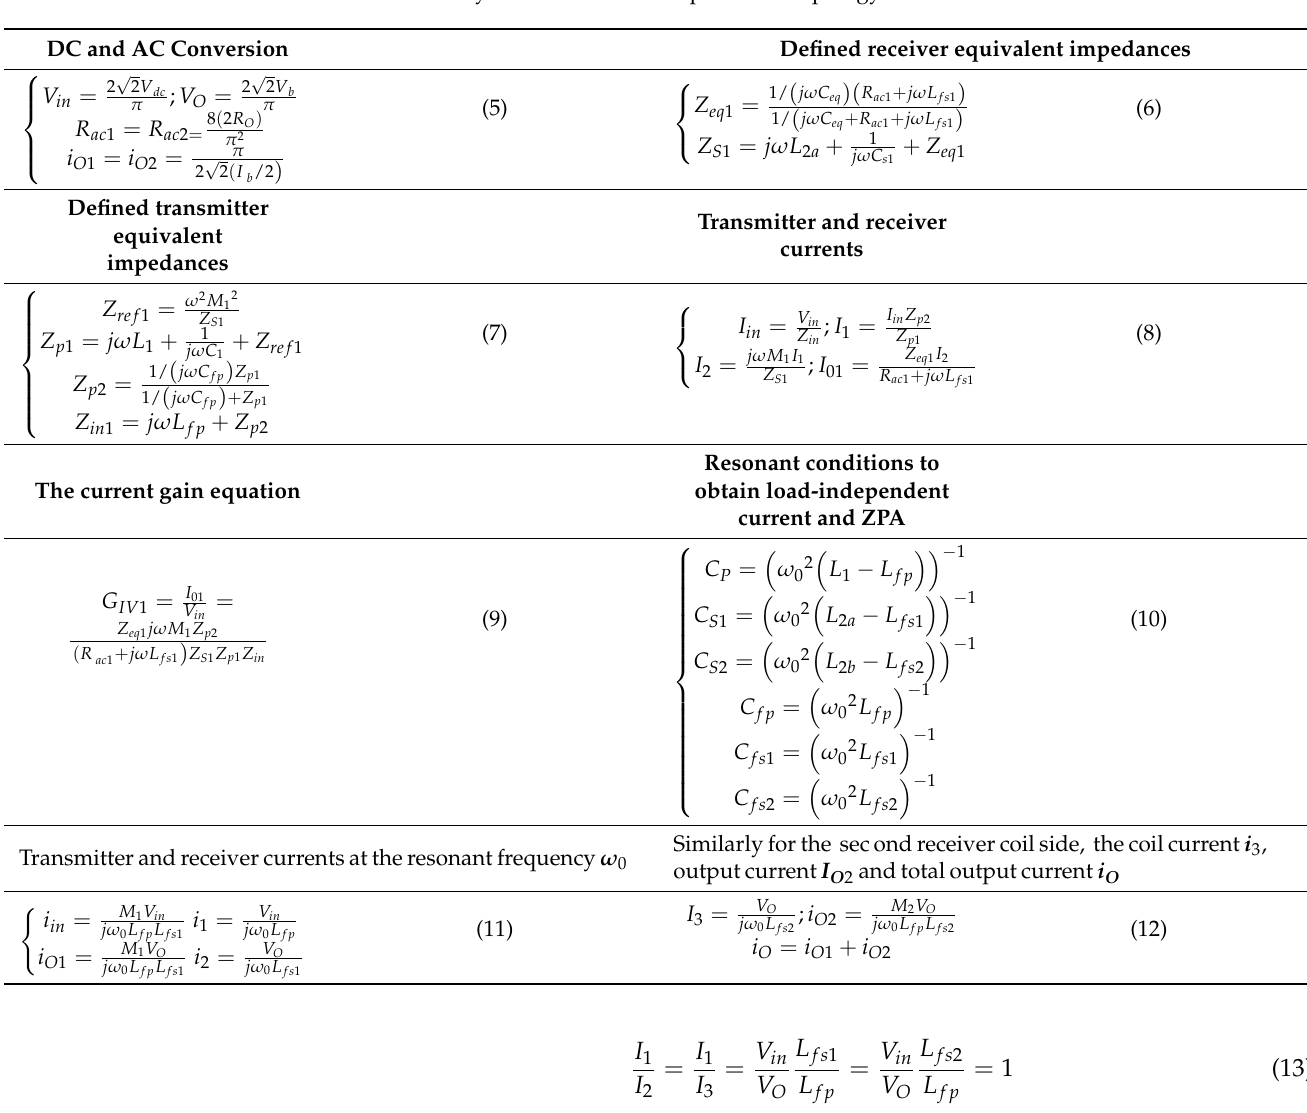
Table 10. Analysis of LCC-LCC compensation